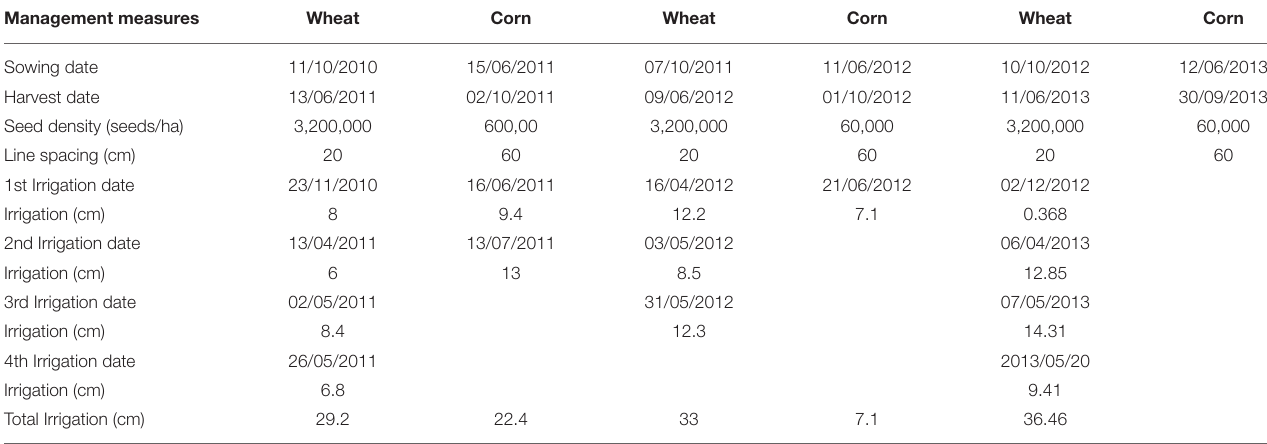
TABLE 3 | Management measures during winter wheat and summer maize seasons from 2010–2011 to 2012–2013, at Luancheng Agro-Ecosystem Experimental Station (LAEES). Management